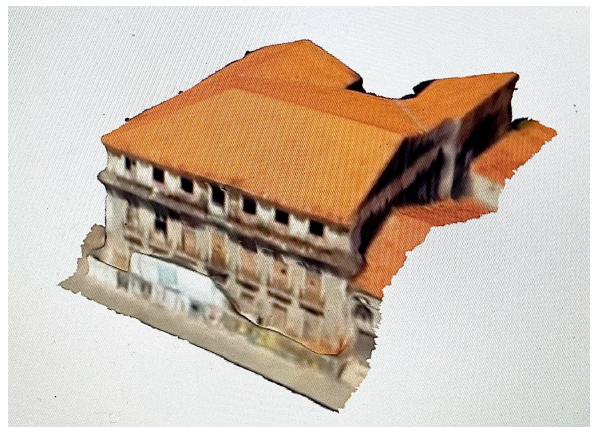
Figure 10. 3D model generated using point